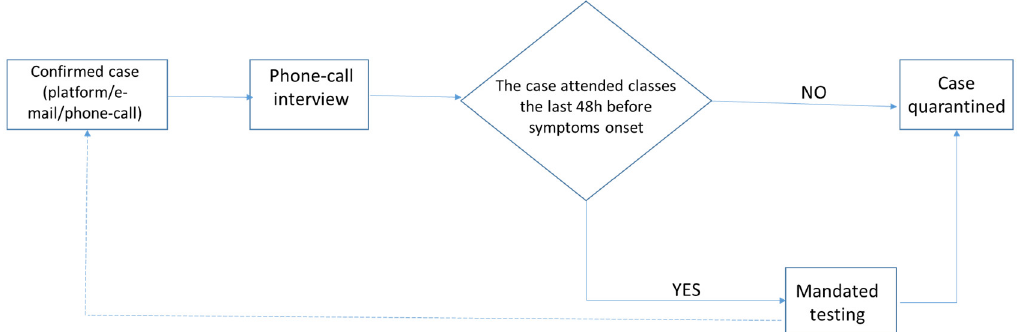
Figure 1. COVID-19 confirmed cases’ management protocol flowchart. Statistical analysis was performed using the MS Excel. The data in this study were analyzed using simple descriptive statistics and inferential statistics hypotheses’ testing, where a significance level of 5% was